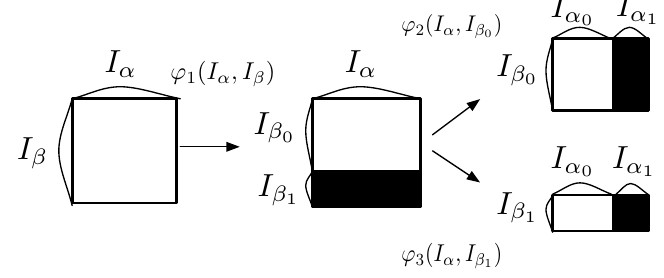
Figure 2. Decomposition of space I α × I β . First, the region is divided by ϕ i . Next, the positive region in white is divided by ϕ 2 , Finally, the negative region in black is divided by ϕ 3 . This procedure is iterated until all space cannot be